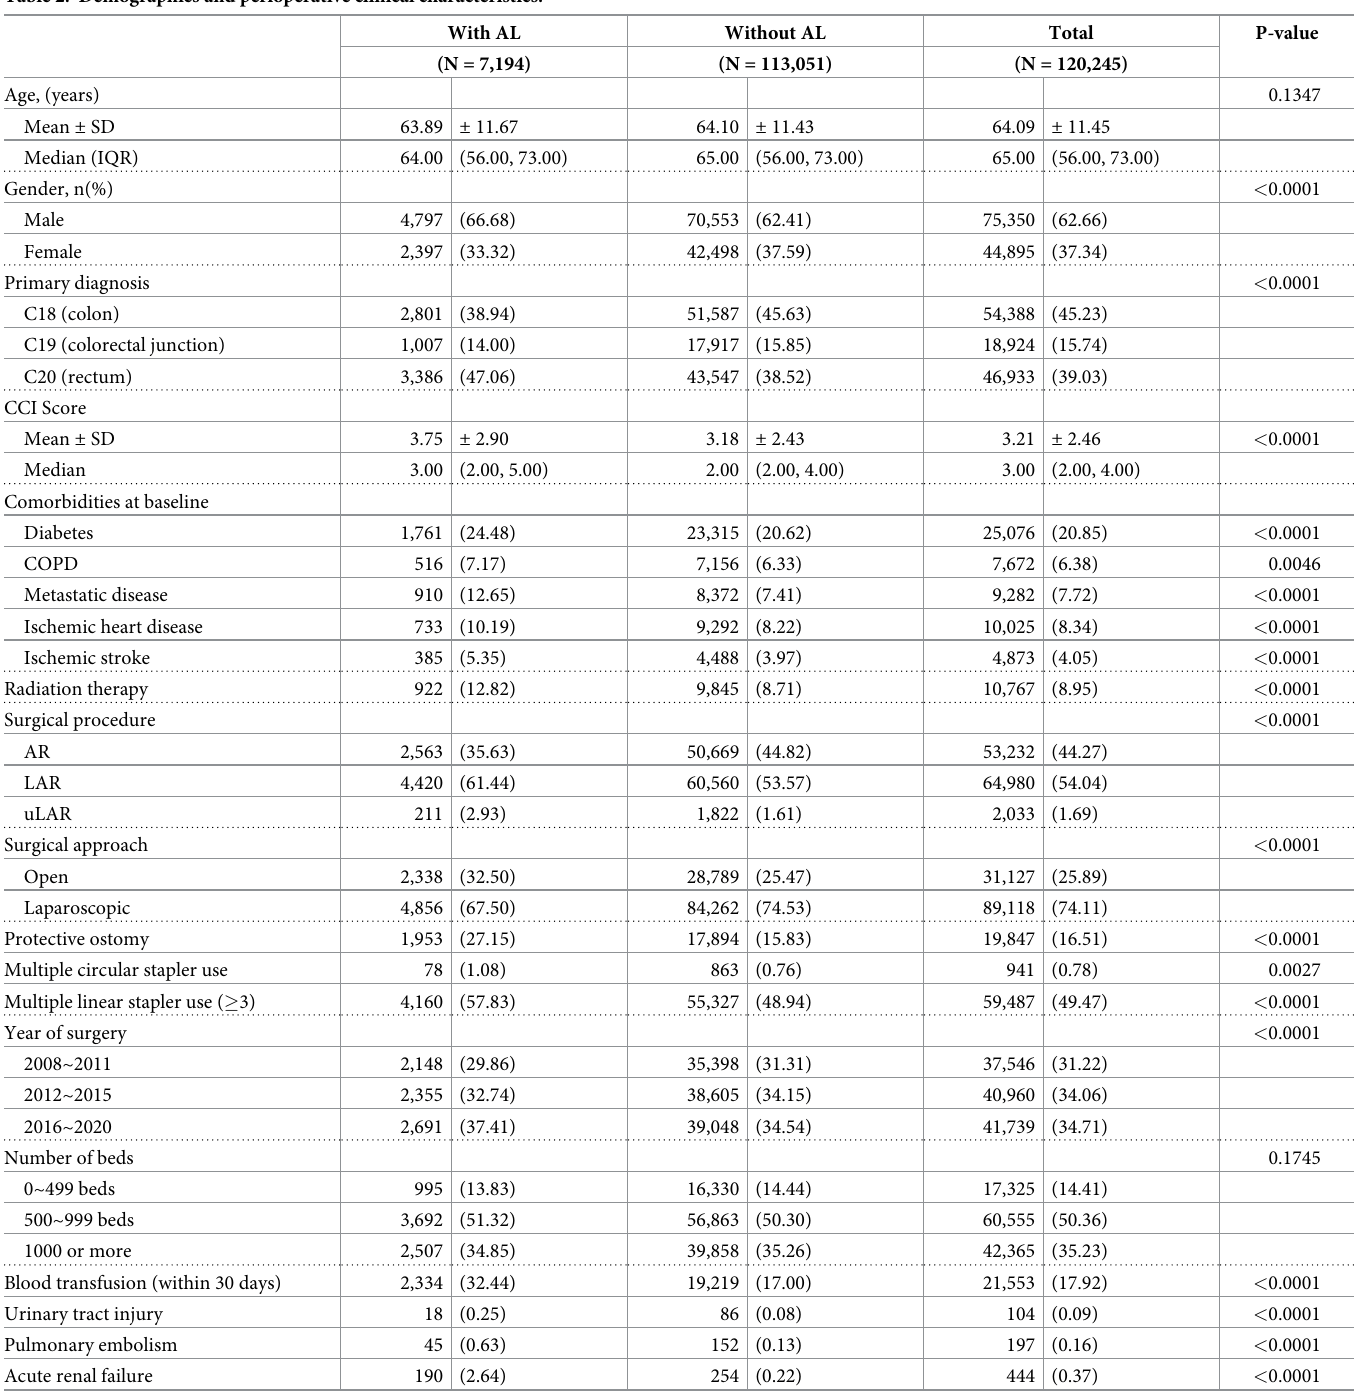
Table 2. Demographics and perioperative clinical